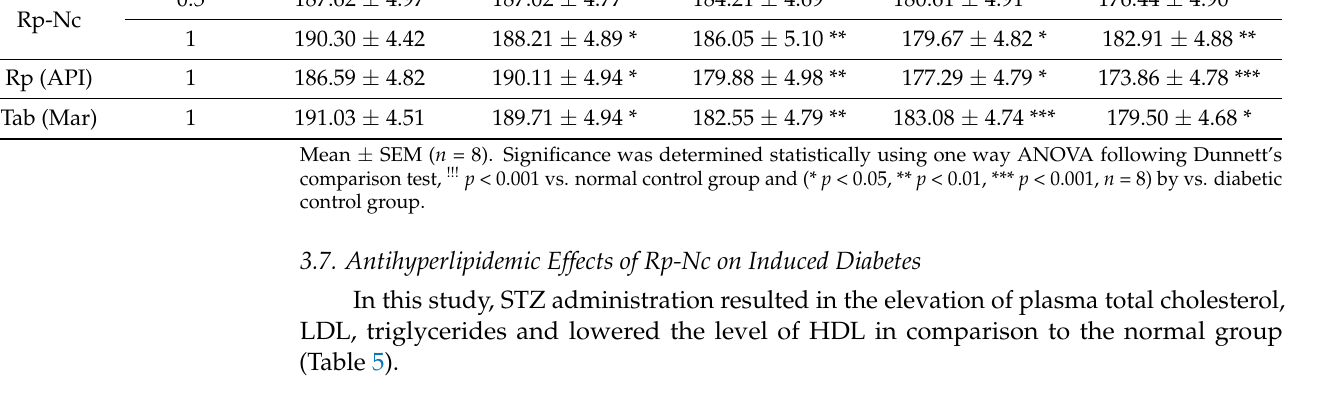
Table 5. Antihyperlipidemic effects of Rp-Nc.